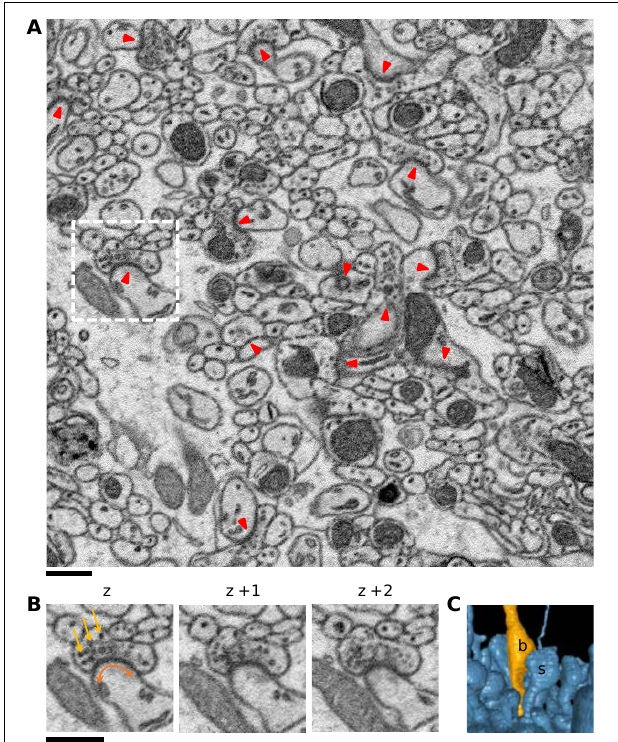
FIGURE 1 | Image resolution is enough for visual identification of synapses and synaptic structures. (A) Various examples of synapses between different types of neuronal fragments are shown. They have presynaptic vesicles (small blobs) and postsynaptic density (a dark blurring or thick line on the membrane) regardless of the types. The red triangles point the synapses from the postsynaptic side. (B) About 3 consecutive sections of images for a synapse corresponding to the white dashed box. The yellow arrows point a few examples of neurotransmitter vesicles, and the curved brown arrow indicates the range of postsynaptic density. (C) 3D mesh rendering of the two neuronal fragments in the vicinity of the images in panel (B) . The label “b” denotes the bouton, and “s” denotes the spine. Scale bars: 600 nm, 50